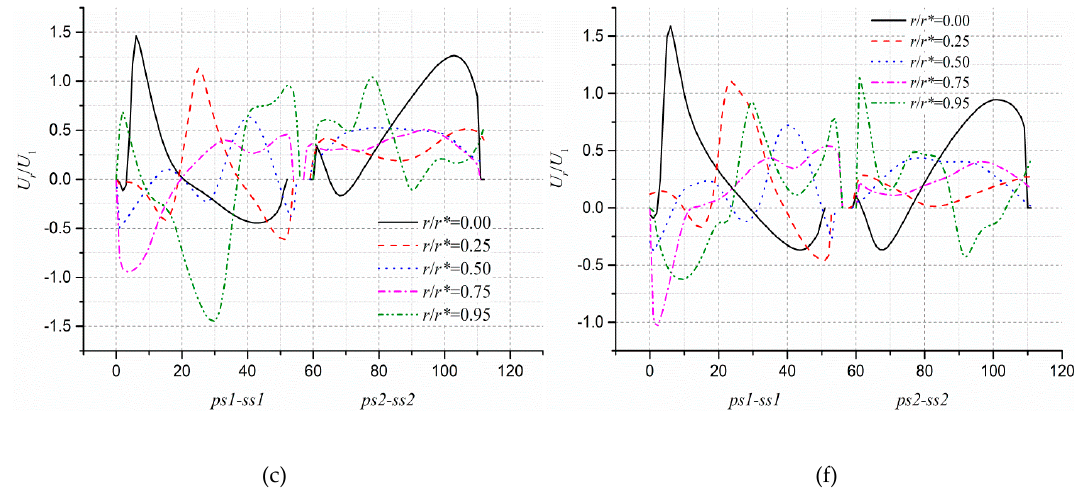
Figure 14. Blade-to-blade distribution of instantaneous radial velocity for the Z / b 2 = 0.5 cross section: ( a ) t = 1/12 T , ( b ) t = 3/12 T , ( c ) t = 5/12 T , ( d ) t = 7/12 T , ( e ) t = 9/12 T , and ( f ) t = 11/12 T .